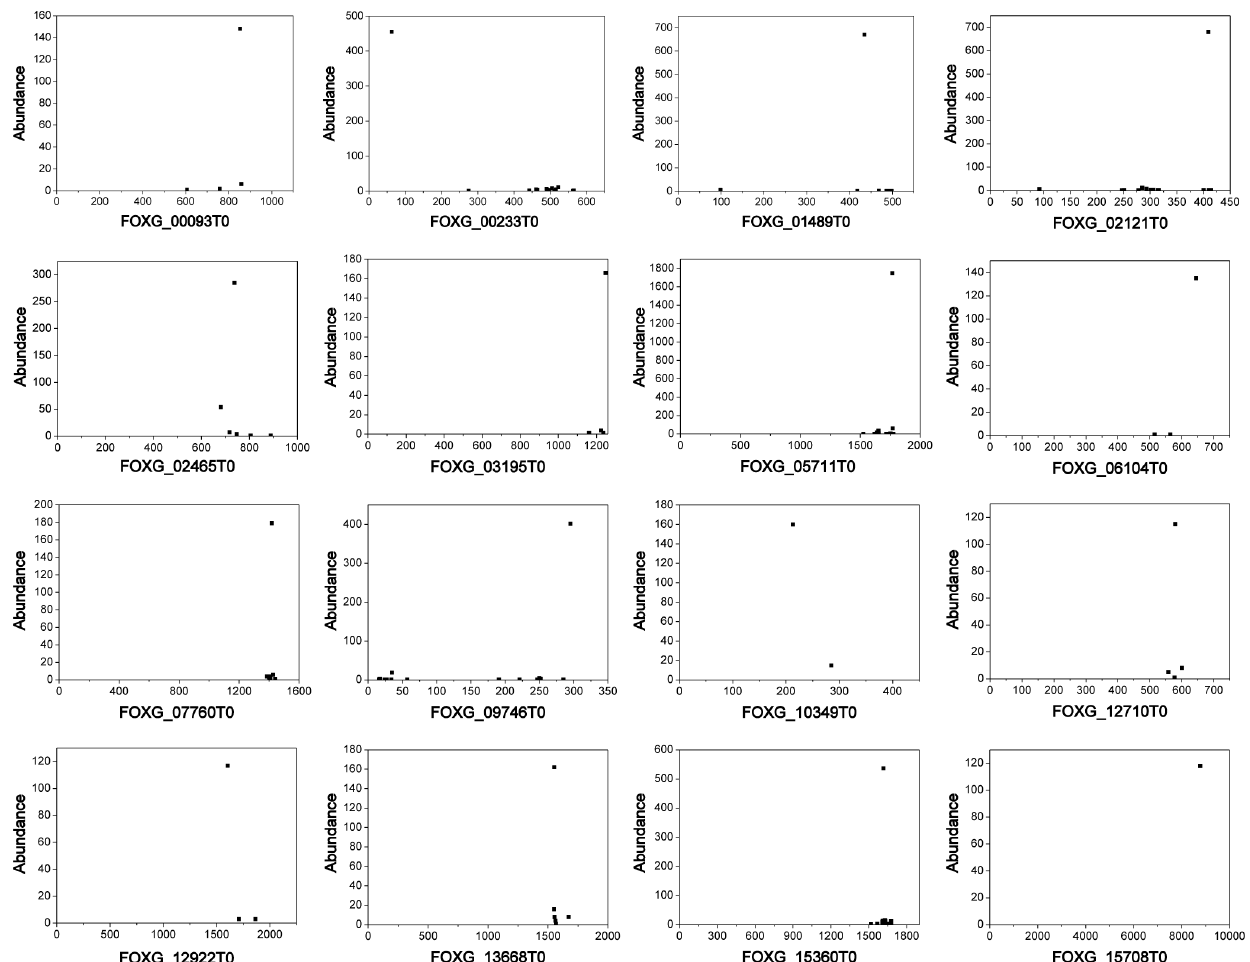
Figure 3. Scatter plot diagrams of degradome data on transcripts. The 16 most abundant signals with high peak-to-total ratio ( . 0.8) were selected and illustrated. The x and y axis of each diagram represent position of transcripts and the frequency of tags, respectively. Each tag perfectly matching the transcripts was plotted. However, none of these peak signals correspond to predicted cleavage sites of any small RNAs of F. oxysporum . These truncated transcripts might be particularly stable decay intermediates or products of special endonuclease.